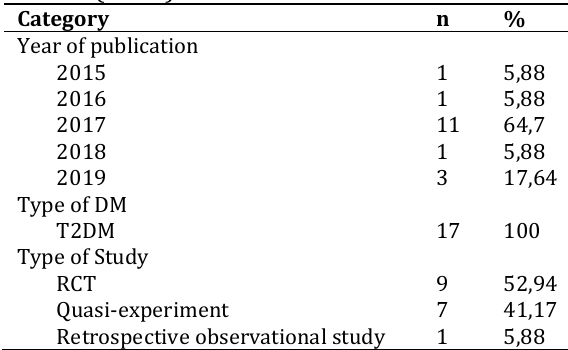
Table 1. General characteristics of the selected studies